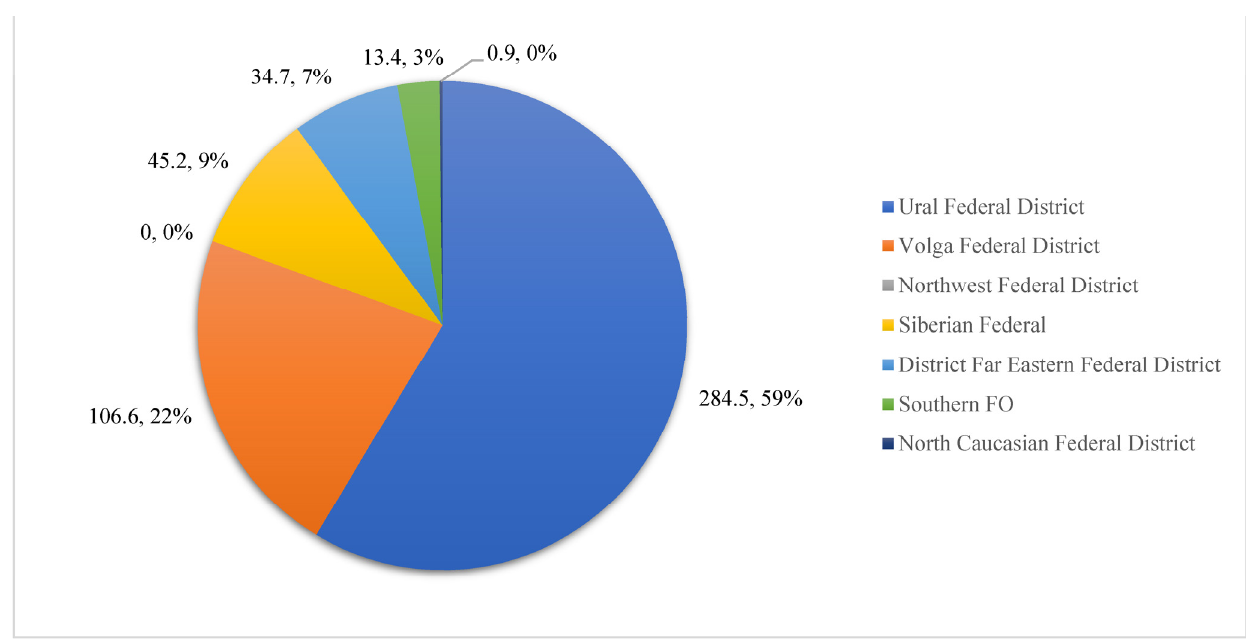
Figure 3. Grouping of federal districts of the Russian Federation by oil production volume, 2020. Com- piled by the authors according to: Regions of Russia. Socio-economic indicators. 2021. 612–613. [Elec- tronic resource]. Access mode: https://rosstat.gov.ru/storage/mediabank/RegionPokaz_2021.pdf; Oil production by the subjects of the Russian Federation (thousand tons) Electronic resource] ((date of application 7 October 2021). Access mode: